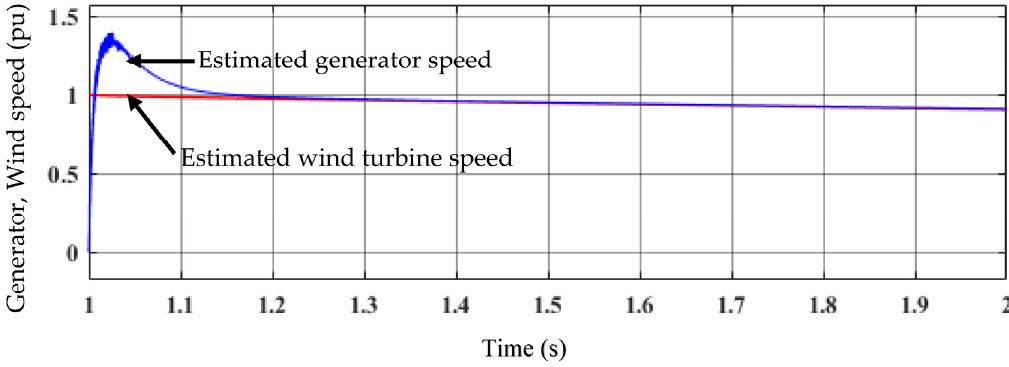
Figure 12. Estimated generator speed and estimated wind turbine speed.